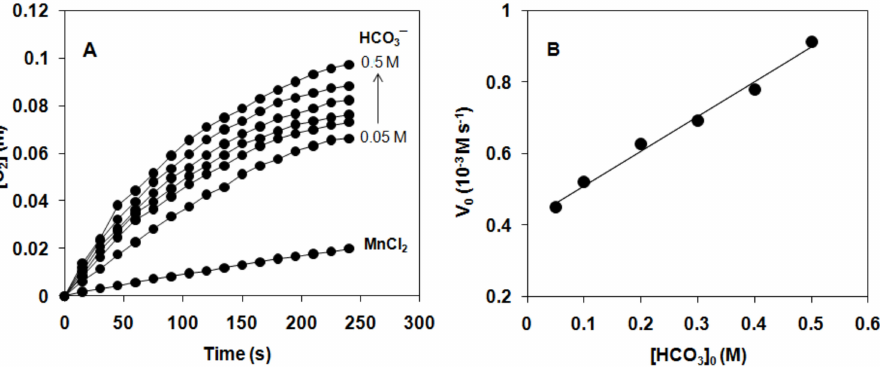
Figure 4. Kinetic analysis for the hydrogen peroxide degradation catalyzed by MnCl 2 and [Mn II (HL 1 )Cl 2 ] ( 1 ) in bicarbonate bu ff er (pH = 9.6). ( A ) Time traces for the reaction of MnCl 2 and 1 with H 2 O 2 in the presence of bicarbonate. ( B ) Dependence of the reaction rate on the bicarbonate concentration for the [Mn II (HL 1 )Cl 2 ]-catalyzed disproportionation of H 2 O 2 . Conditions: